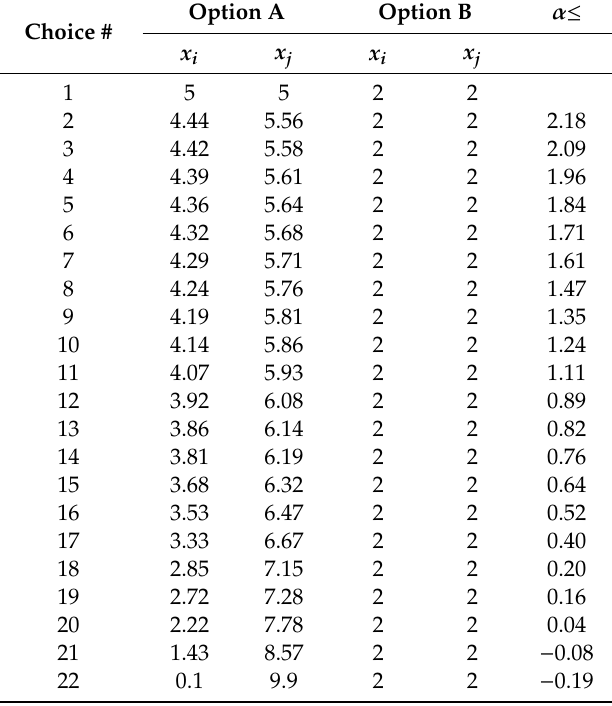
Table A1. Menu choice for Alpha F&S elicitation.